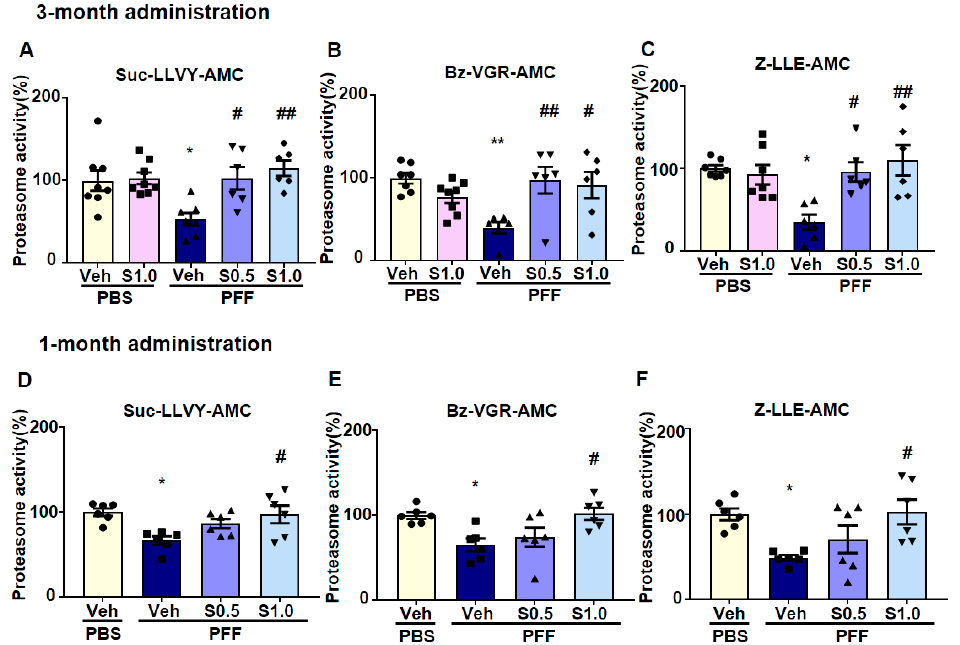
Figure 5. SAK3 administration rescues the decrease in proteasome activity in α -Syn PFF-injected mice. Proteasome activity assay using fluorogenic peptides ( A , D ) Suc-LLVY-AMC (chymotrypsin-like), ( B , E ) Bz-VGR-AMC (trypsin-like), and ( C , F ) Z-LLE-AMC (caspase-like) on the brain’s cortical region in both schedules ( n = 6–8 per group). Error bars represent SEM. * p < 0.05, ** p < 0.01 vs. vehicle-treated PBS-injected mice; # p < 0.05, ## p < 0.01 vs. vehicle-treated α -Syn PFF-injected mice. Abbreviations: Veh = vehicle; S =